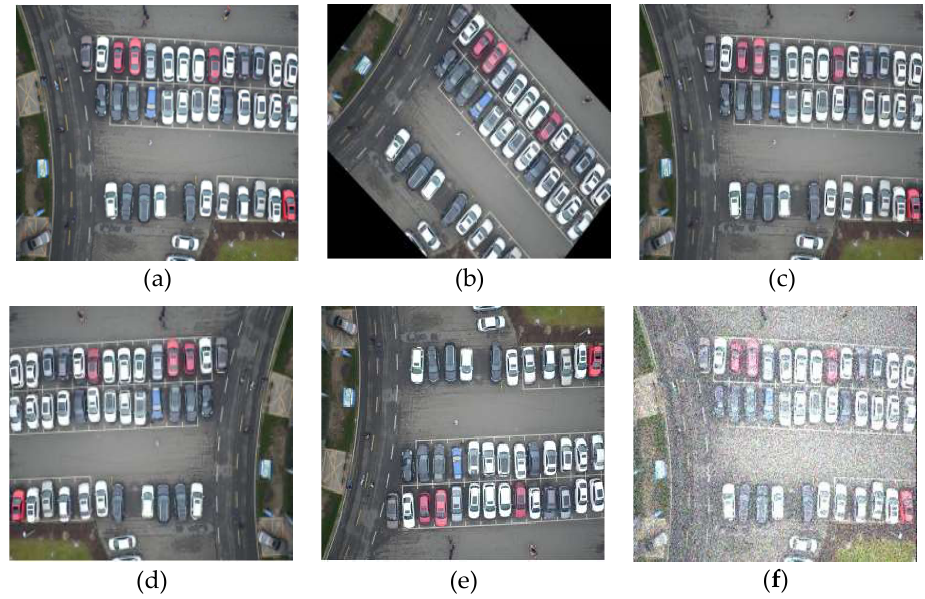
Figure 8. Data augmentation diagram: ( a ) Original image; ( b ) random rotation; ( c ) sharpness adjustment; ( d ) flip left and right; ( e ) flip up and down; ( f ) random Gaussian noise.